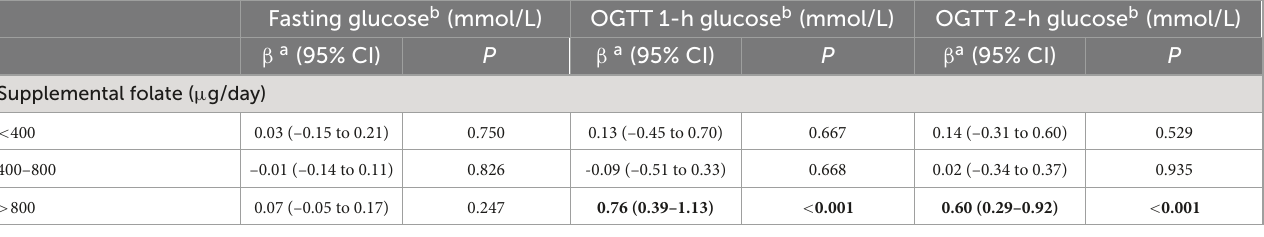
TABLE 5 Association of ART with maternal glucose concentrations, stratified by supplemental folate. Fasting glucose b